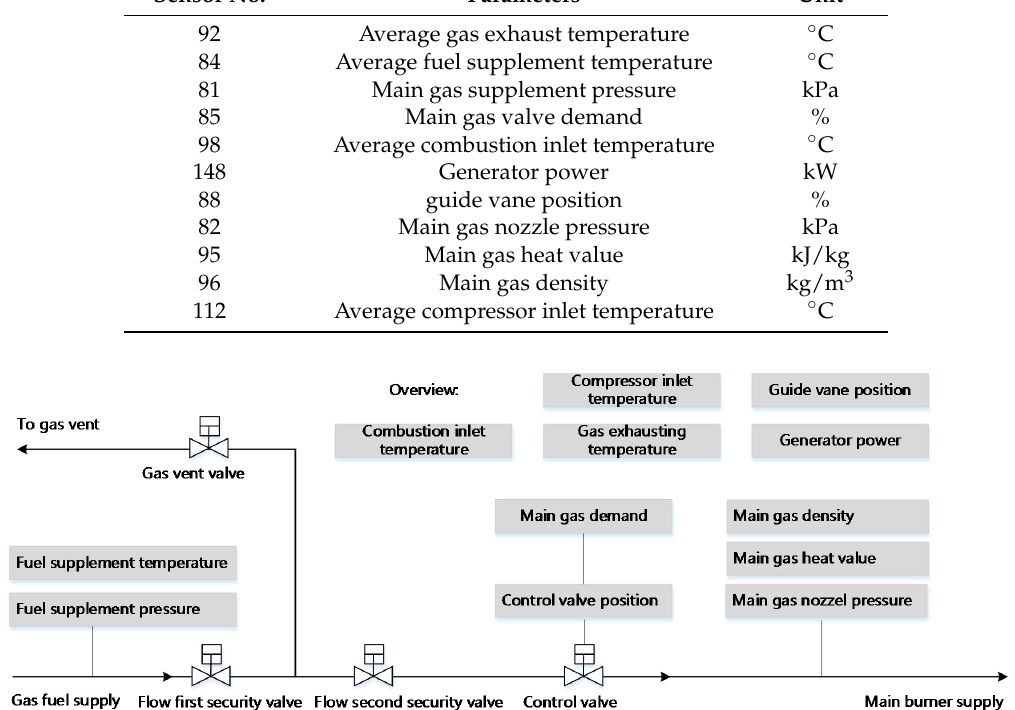
Figure 3. Overview on SOLAR Gas Turbine fuel system.